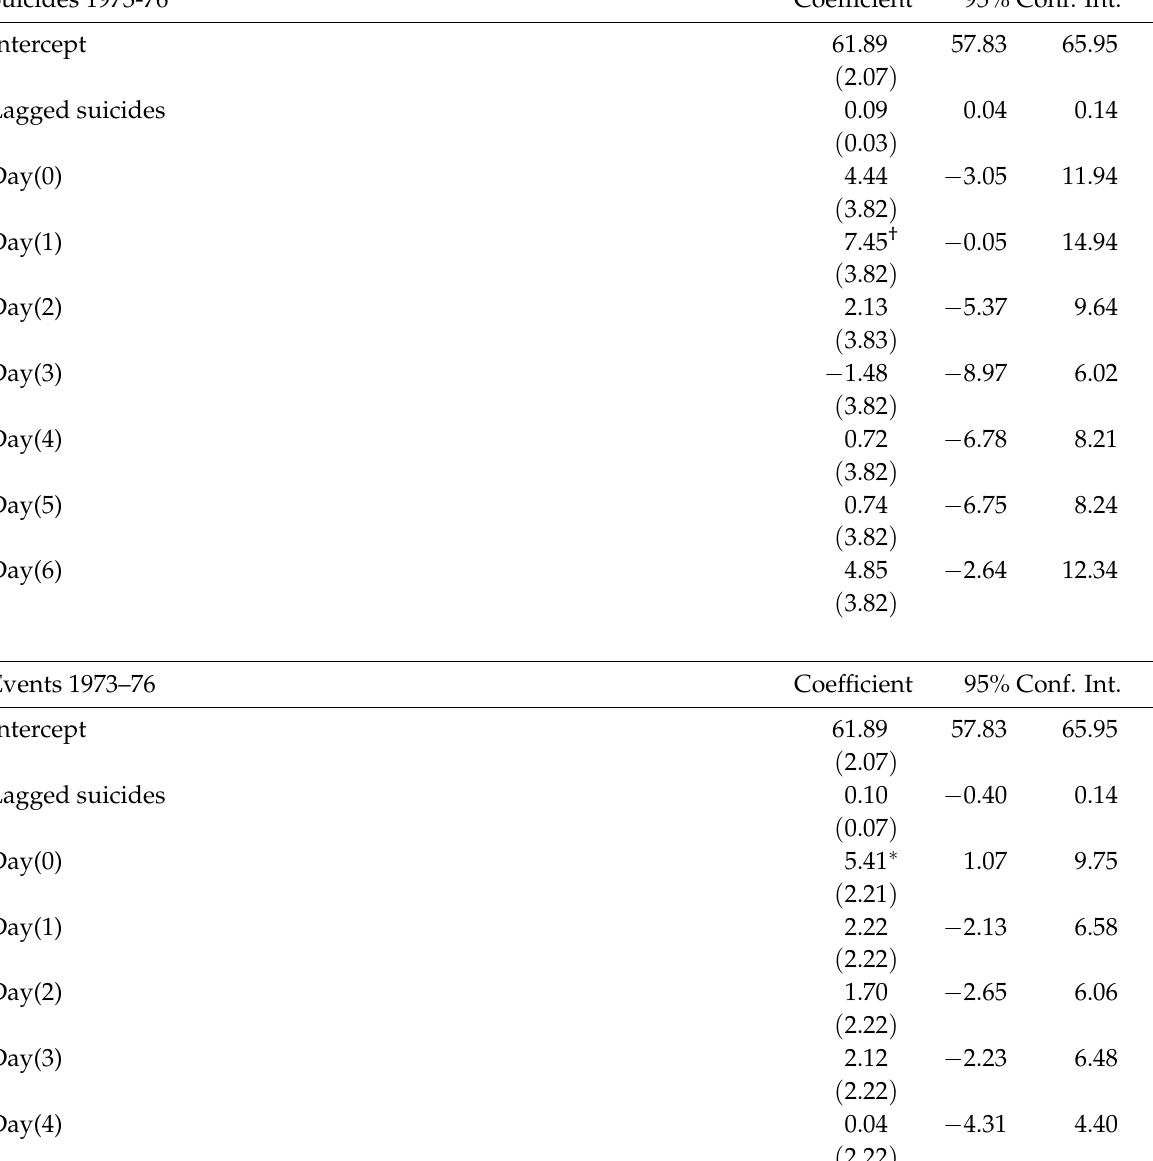
Table 2: The effect of celebrity suicide and exceptional events on daily suicide, 1973-1976 Suicides